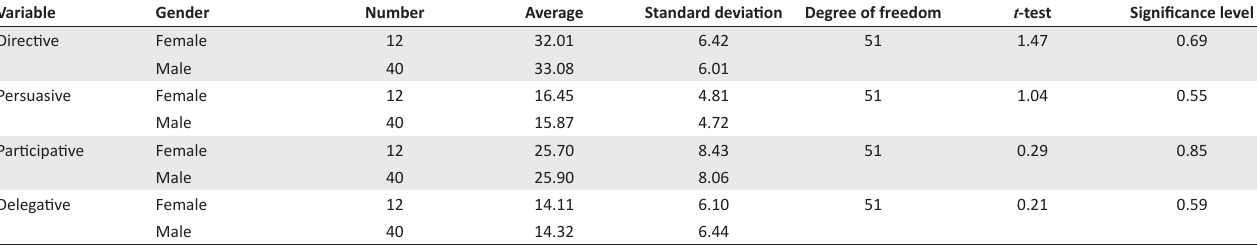
TABLE 2: Studying the difference between the leadership style of male and female managers. Variable